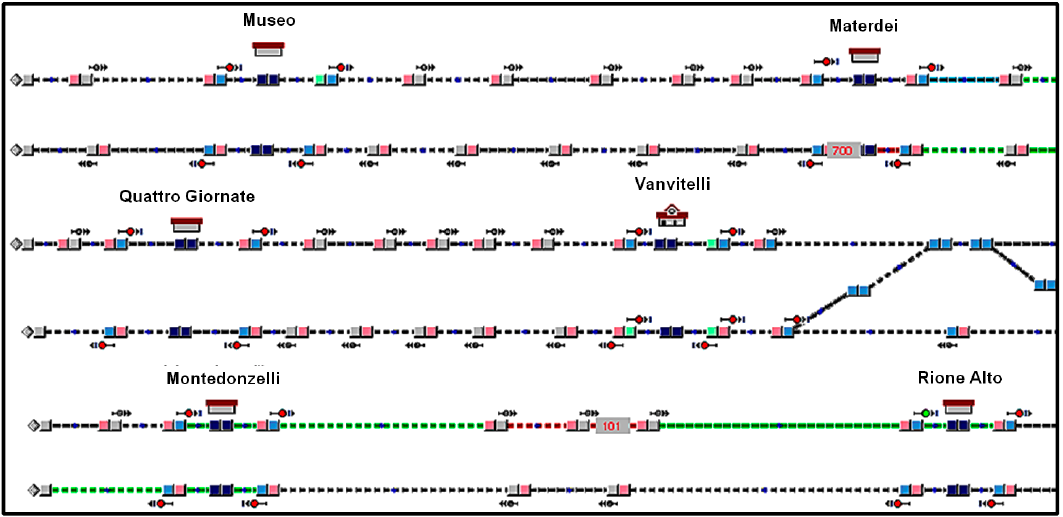
Figure 6. Detail of the supply model implemented in OpenTrack.